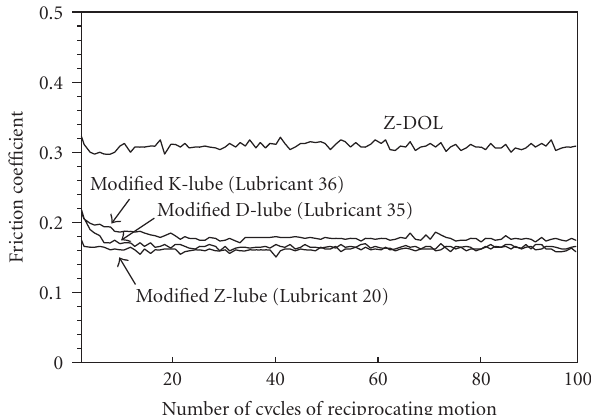
Figure 18: Frictional properties of the three types of the modified PFPEs using stearyl amine. The conventional Z-DOL is shown for comparison.